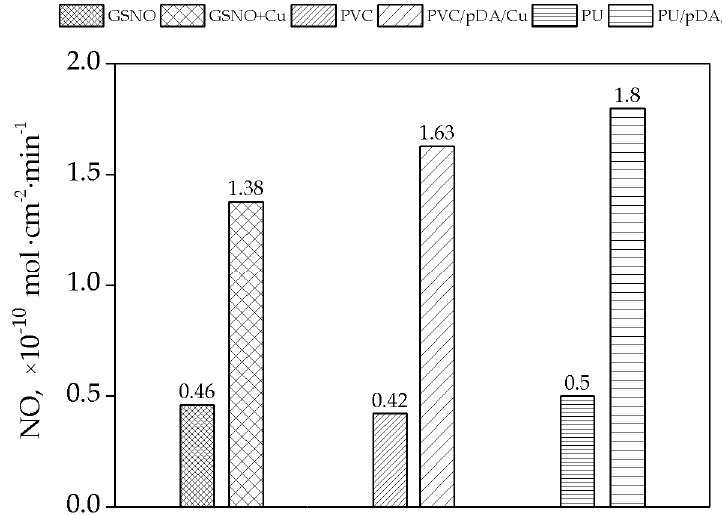
Figure 6. NO generation after incubation of Cu-modified polymers with 100 μ M GSNO/GSH in the PBS during 1 h.